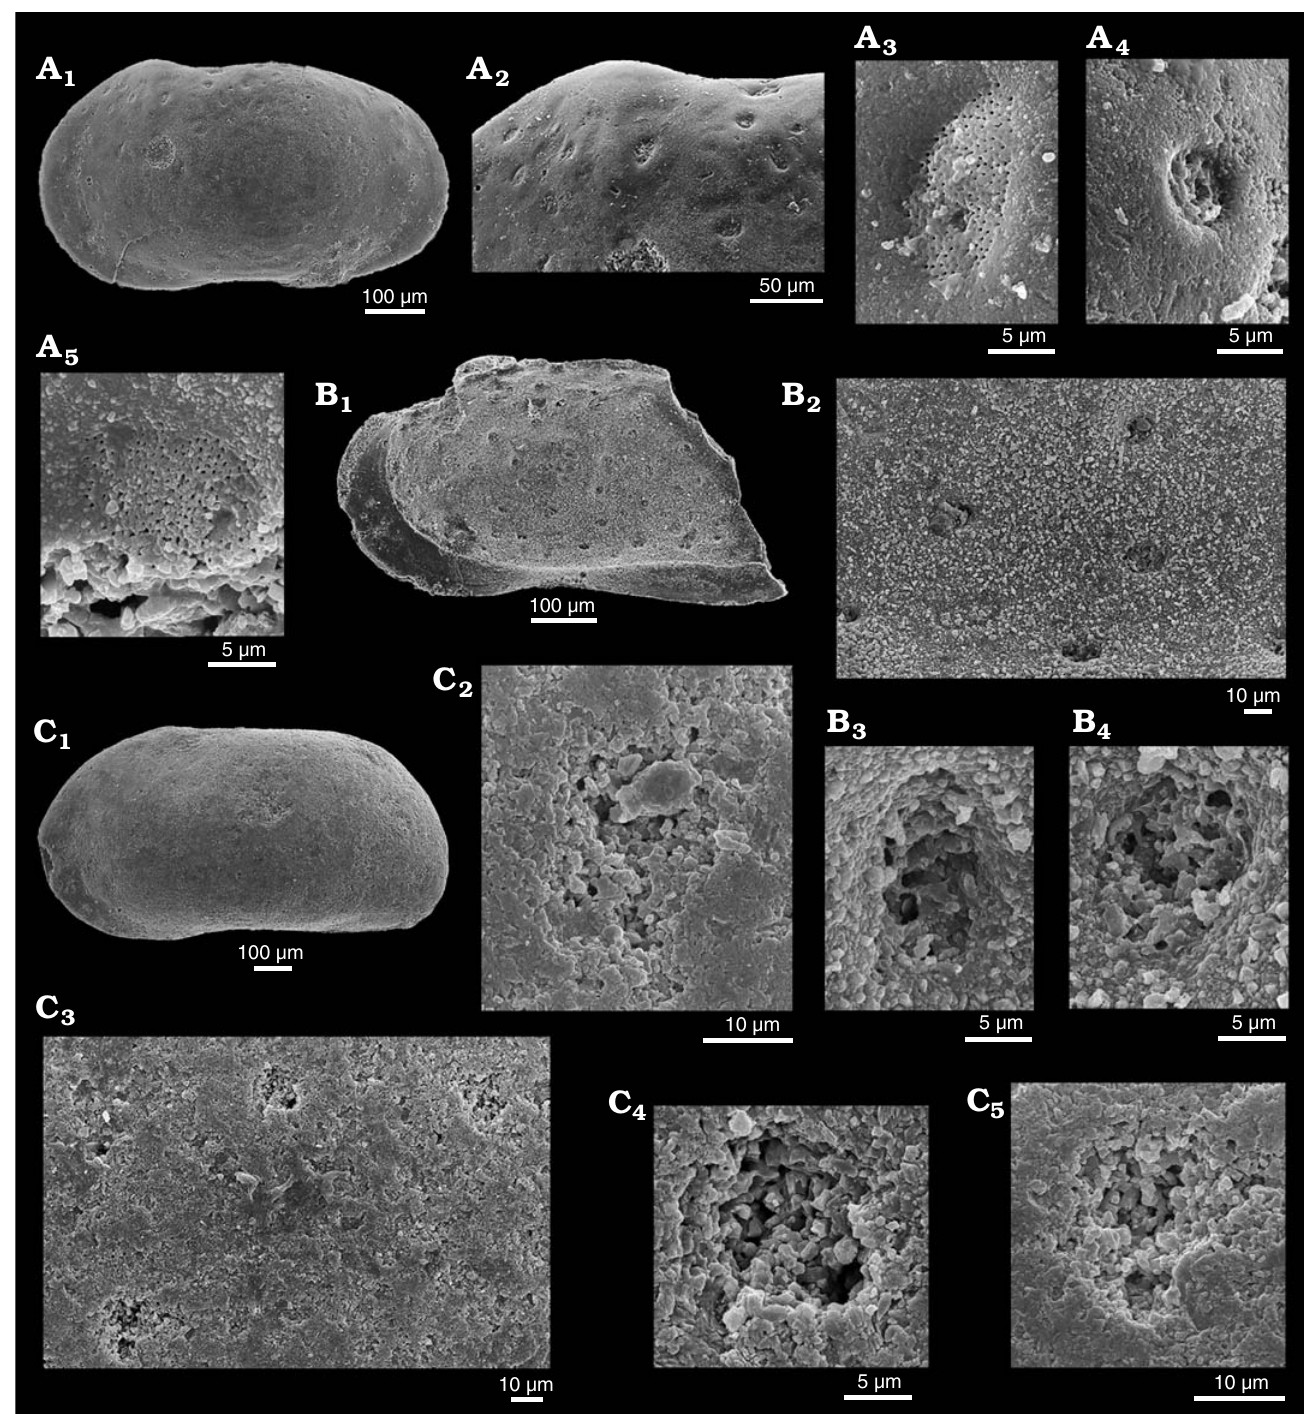
Fig. 2. Sieve-type normal pore canals (StPC) in Phraterfabanella spp. A , B . Phraterfabanella tridentinensis Whatley and Boomer in Boomer et al., 2001, from Rotzo Member, Calcari Grigi Formation, Trento Platform, Venetian Prealps, NE Italy, Upper Sinemurian, Lower Jurassic. A . SMF Xe 23715, female left valve, in external view (A 1 ). Detail of antero-dorsal area (A 2 ), macro StPC (StPC-M) (A 3 ), micro StPC (StPC-m) (A 4 ), and large StPC (A 5 ). B . SMF Xe 23716, male? fragment of right valve, in internal view (B 1 ), StPC-M in general view (B 2 ) and details (B 3 , B 4 ). C . Phraterfabanella boomeri Cabral and Colin, 2015, from Praia da Concha, Coimbra Formation, sample PCR-318, Portugal, Upper Sinemurian, Lower Jurassic. SMF Xe 23717, male carapace, in external left view (C 1 ), StPC-M in general view (C 3 ) and details (C 2 , C 4 , C 5